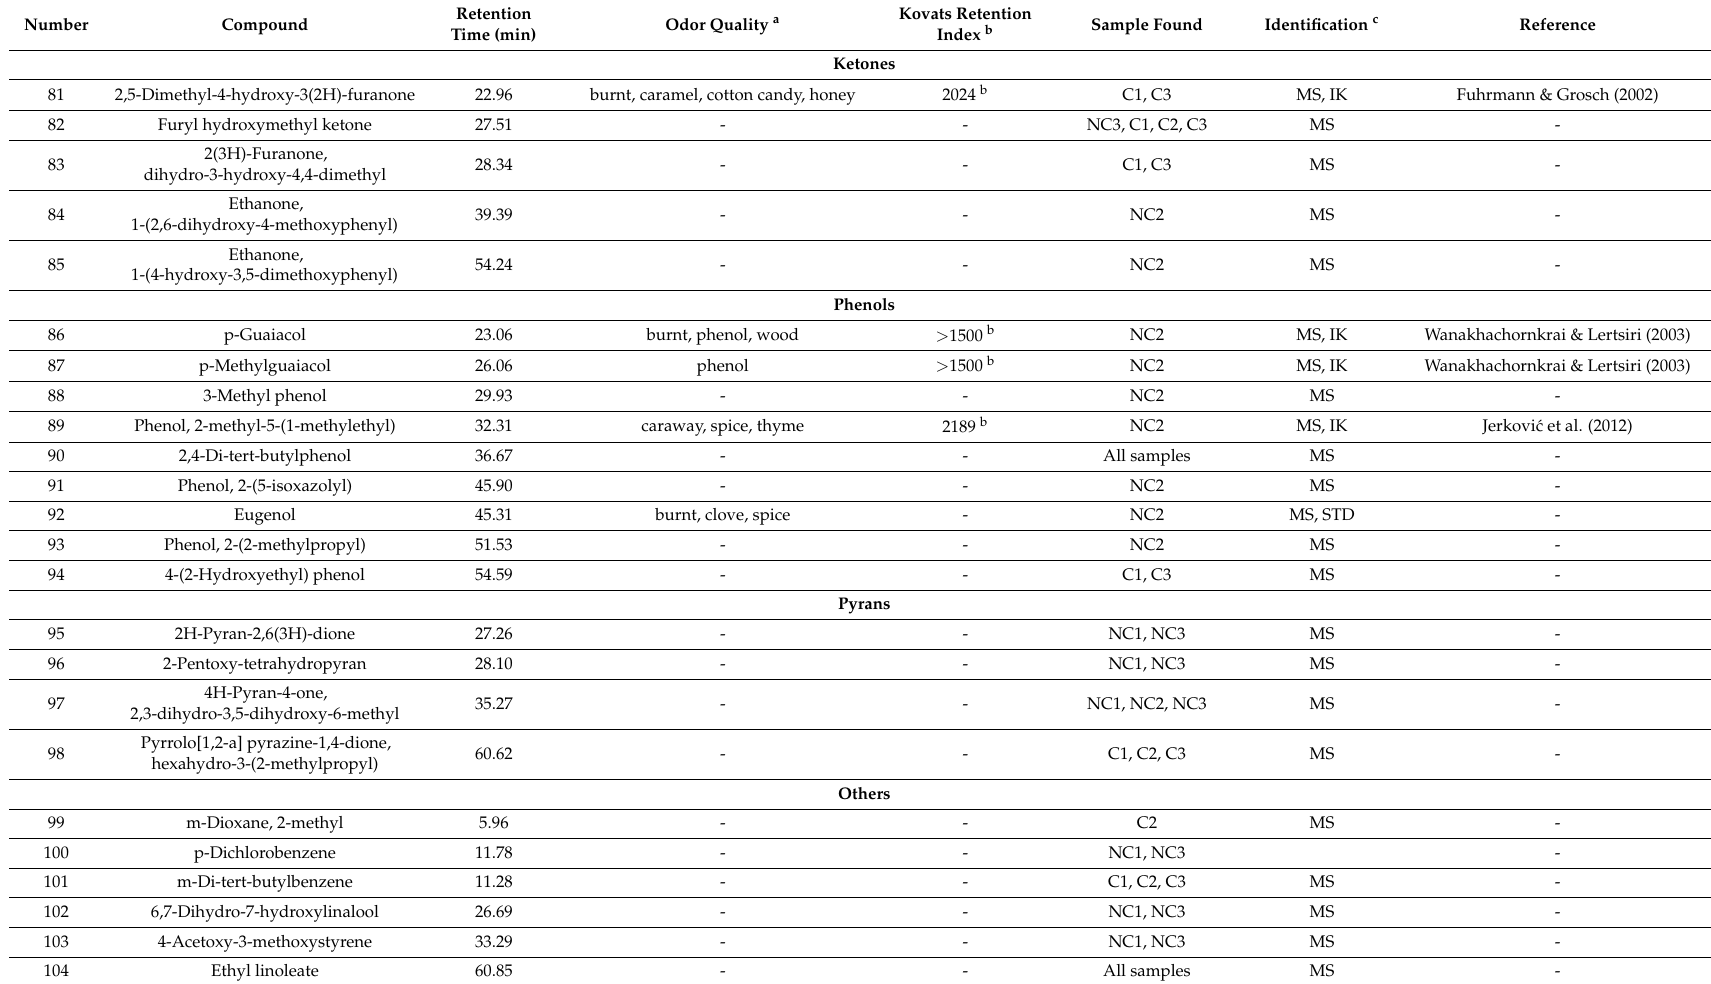
60.85 - - All samples MS